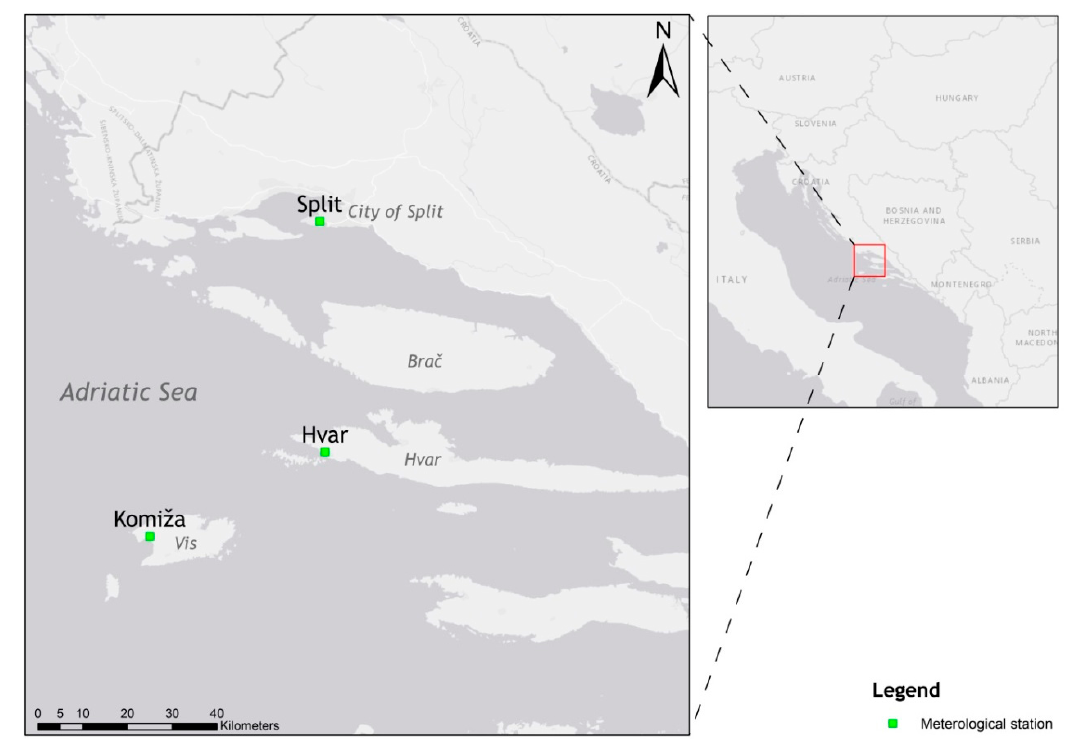
Figure 1. Map of the study area showing the locations of the three meteorological stations whose data were analyzed in this study.